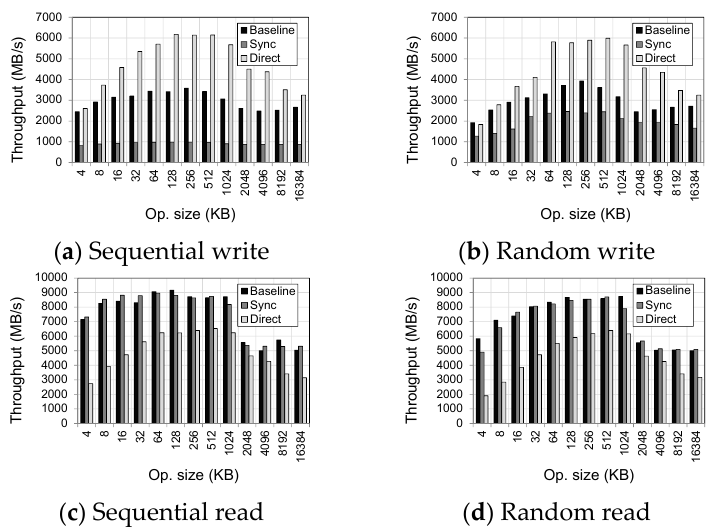
Figure 3. RAMDisk performance under different I/O modes.